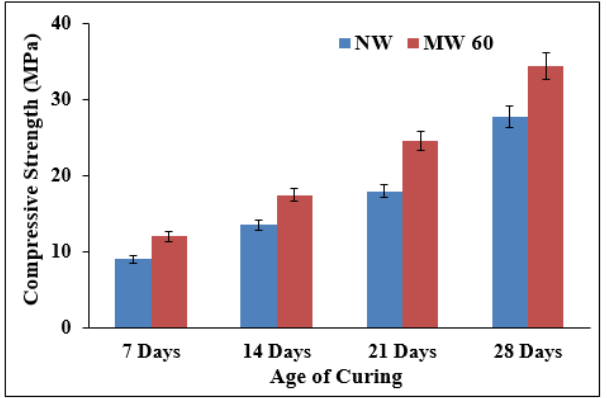
Figure 9. Compressive strength of NWC and MWC.